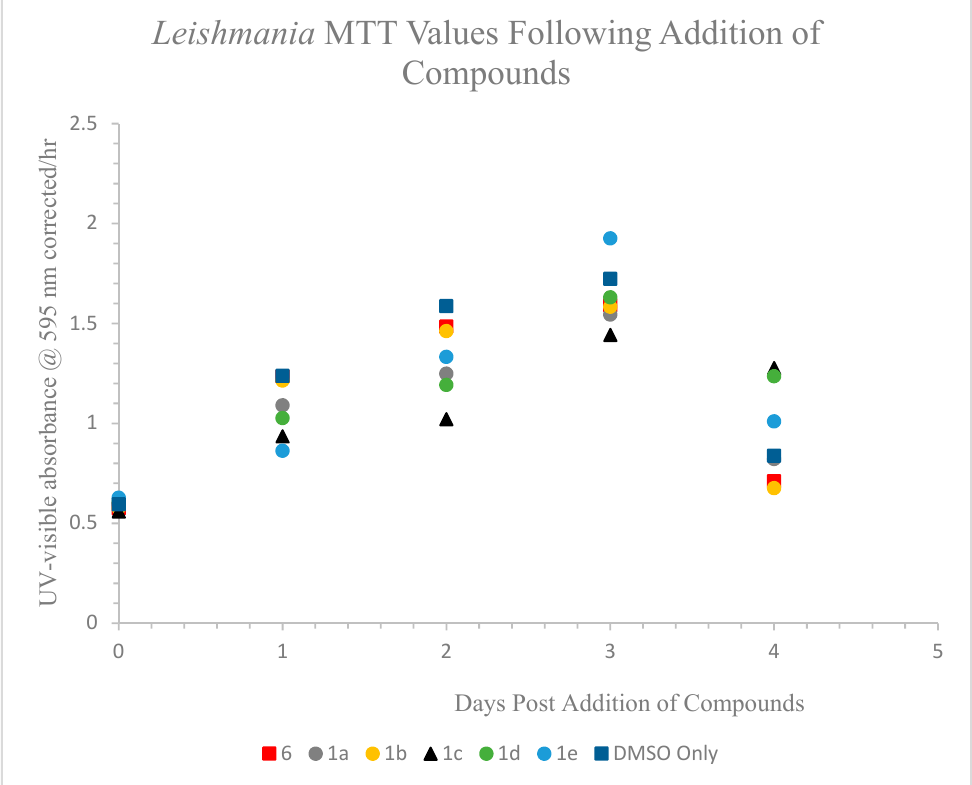
Figure 3. 3-(4,5-dimethylthiazol-2-yl)-2,5-diphenyltetrazolium bromide (MTT) absorbance values from cells exposed to a single dose of 30 µM polycyclic ether-benzopyrans in DMSO were obtained at each interval (0 h and every 24 h subsequently). Values are the mean for n = 4 replicates and all SD were smaller than 2% of the mean. DMSO cells are considered to be the appropriate control.